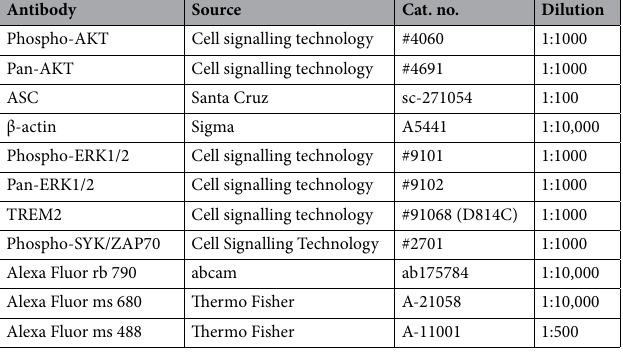
Table 1. Antibodies used in this